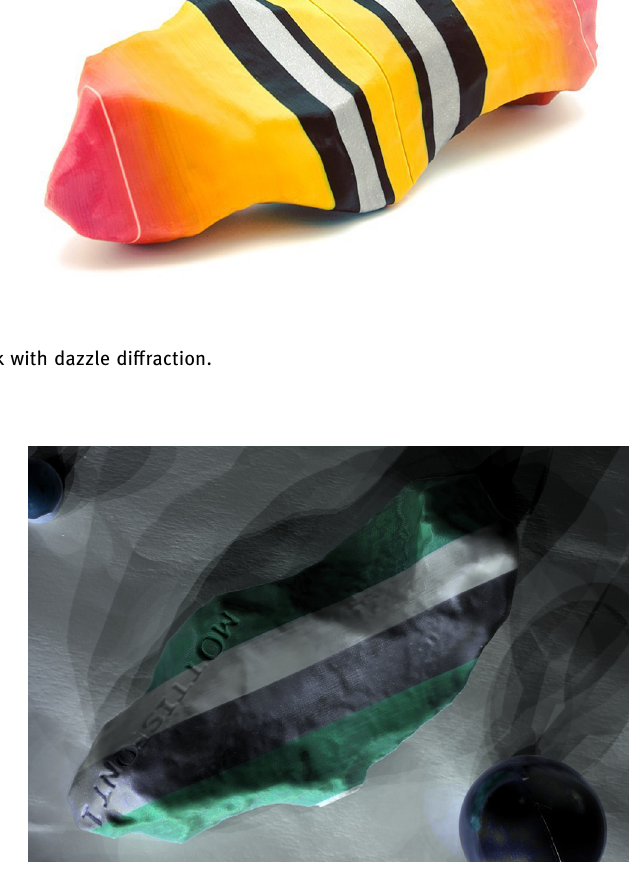
Figure 14: RTI of inscribed PLA pick with oblique green - , white - , and grey -